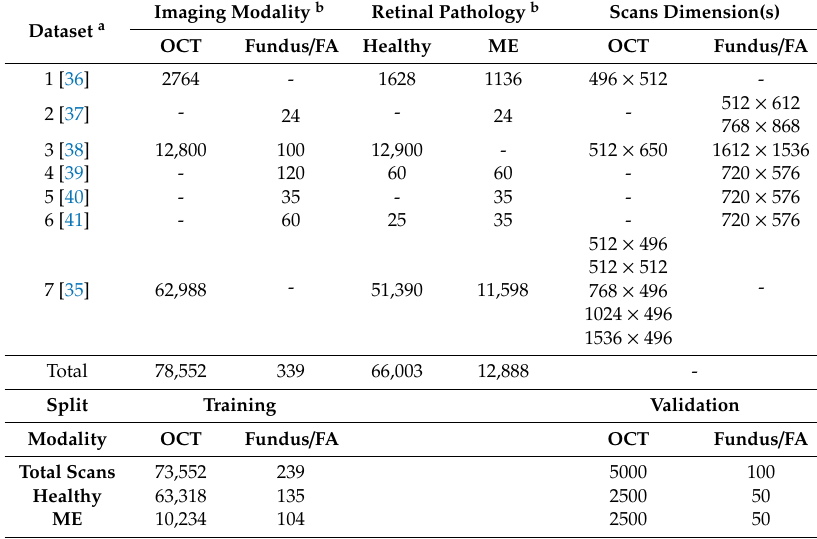
Table 1. Details of the dataset used for training and testing